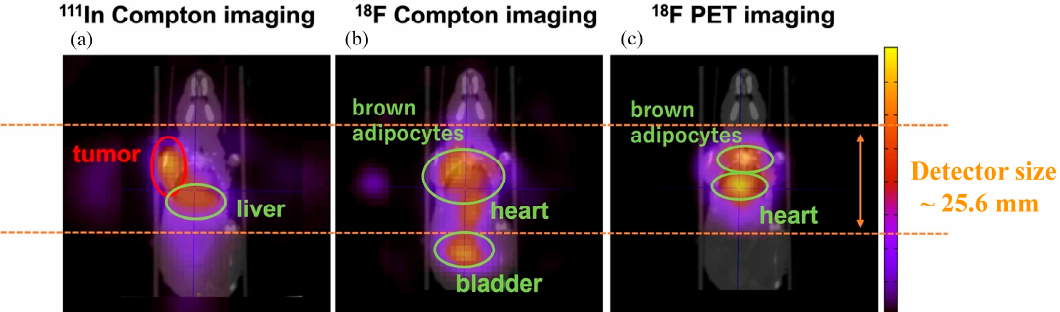
Figure 9. In vivo Compton imaging of accumulation of ( a ) 111 I in mouse tumor and liver, ( b ) 18 F-FDG in heart and bladder, and ( c ) The PET imaging of 18 F-FDG accumulated in mouse heart. The images were superimposed with the CT images [156]. Reproduced with permissions from Uenomachi et al. [156].